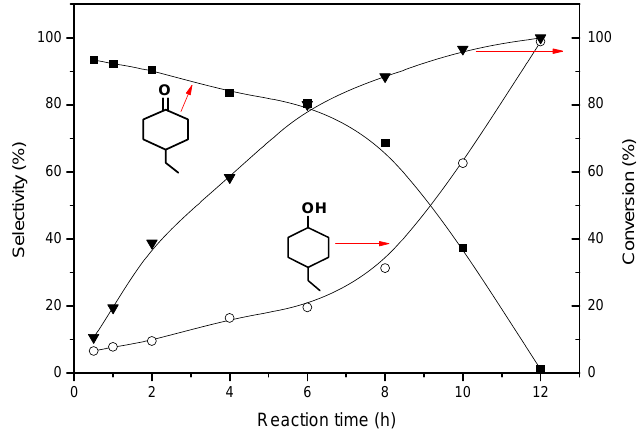
Figure 5. Effect of reaction time on the conversion of 4-ethylphenol and selectivity to products. Reaction conditions: reactant (0.82 mmol), H 2 O (25 mL), 3 wt. % Pd/ γ -Al 2 O 3 (0.200 g/0.056 mmol Pd), 60 °C, 2 MPa H 2 .